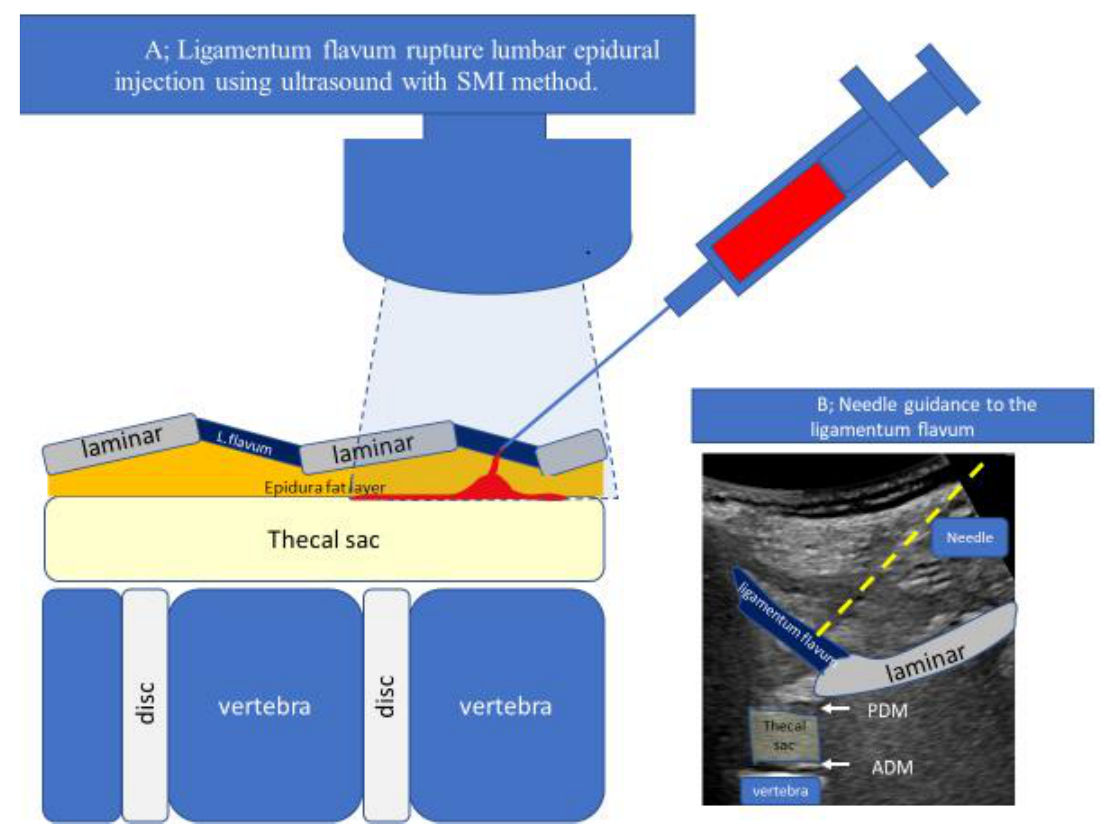
Figure 1. Ultrasound-guided lumbar epidural injection technique. ( A ) Ligamentum flavum rupture lumbar epidural injection using ultrasound with SMI method. The needle was guided in-plane toward the ligamentum flavum via ultrasound (US). The monitor and ligamentous resistance tactile sensation transmitted to the syringe were used to confirm that the needle tip had reached the ligamentum flavum. Once the needle tip reached the ligamentum flavum, the US was switched to superb microvascular imaging (SMI) mode to confirm the spread of the injectant. The syringe was pressed, and the needle was brought close to the epidural fat layer within the ligamentum flavum. We stopped advancing the needle and injected the remaining injectant when the ligamentum flavum ruptured, and the SMI signal appeared in the epidural fat layer. ( B ) Sonogram of needle guidance to the ligamentum flavum. The dotted yellow line indicated the injection needle trajectory. Abbreviations: L. flavum, ligamentum flavum; ADM, anterior dura matter; PDM, posterior dura